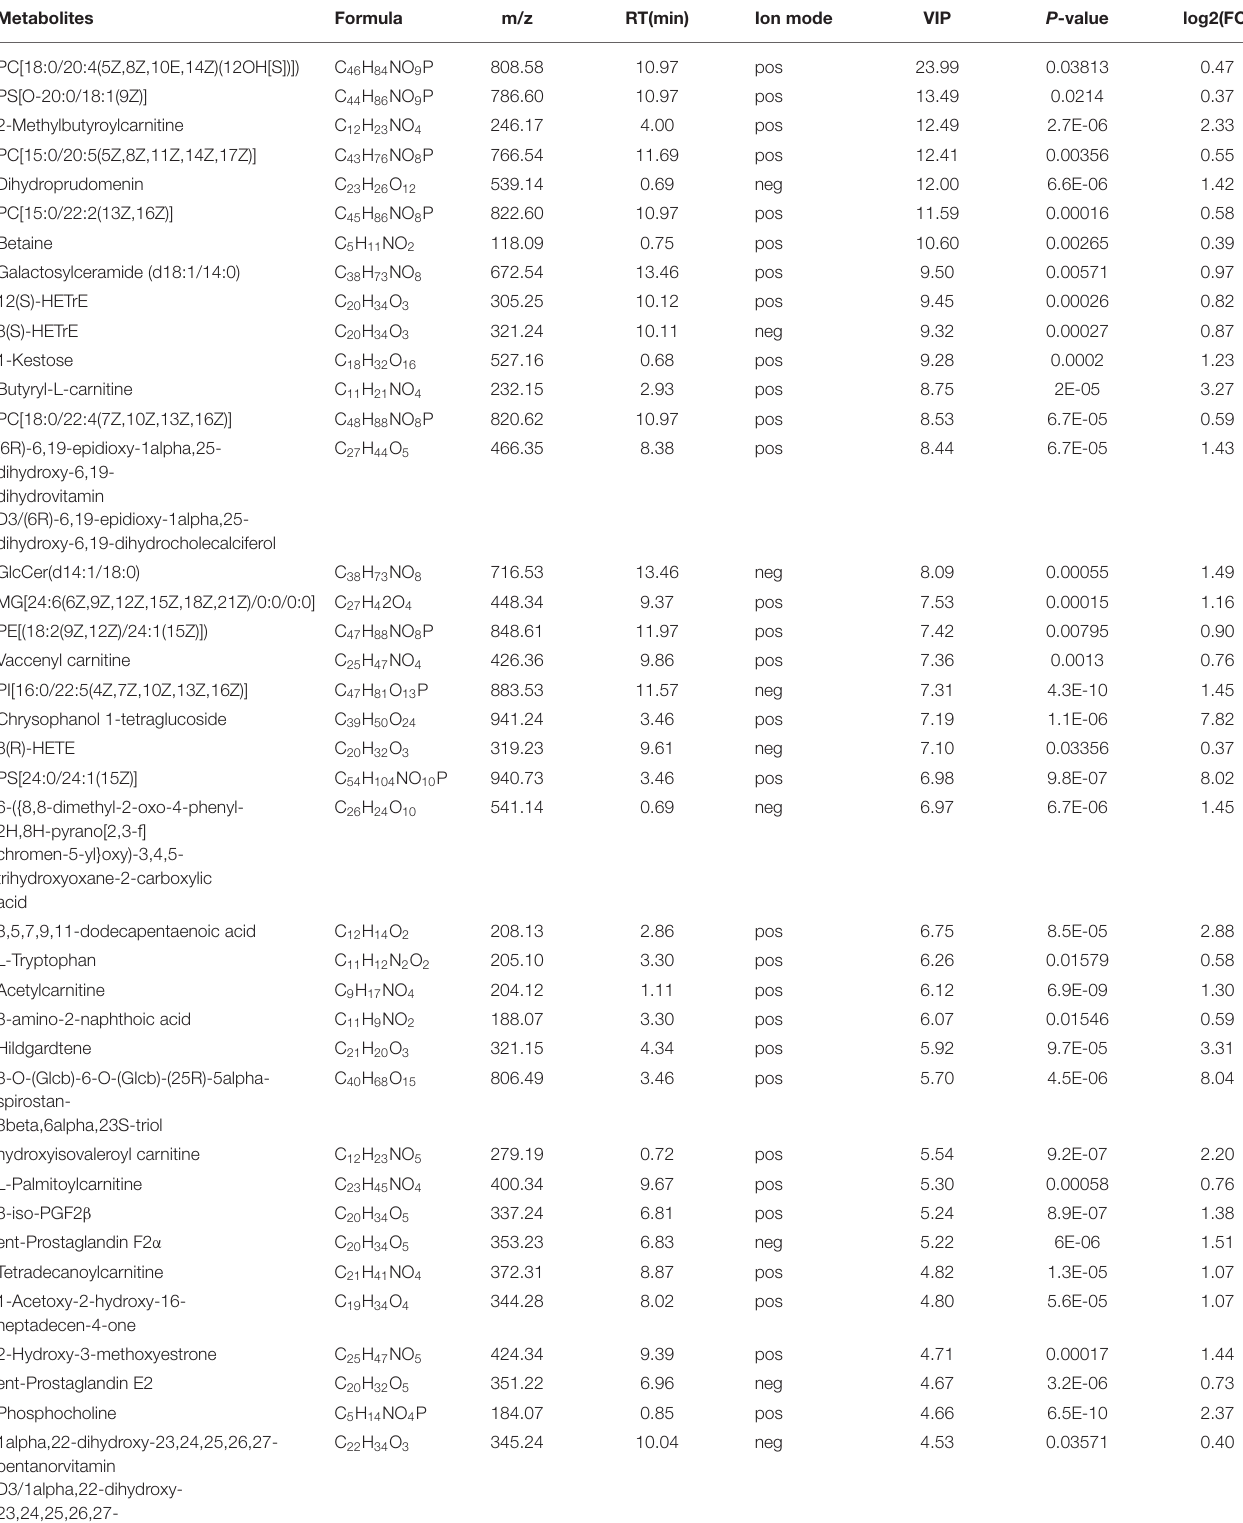
TABLE 1 | Up-regulated metabolites in gills of S.paramamosain response to sudden drop in salinity from 23 to psu. Metabolites